Question: What does this figure show? Answer in one sentence.
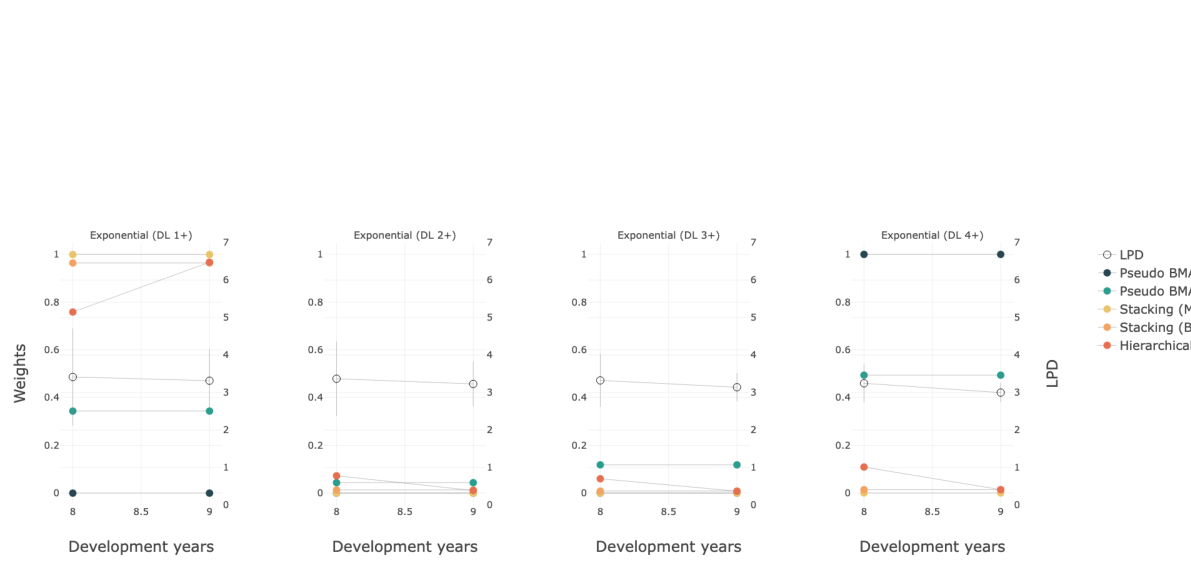
Answer: Model weights and log posterior predictive density (LPD) values from the loss de- velopment example. Model weights are constant across development years for every model except the hierarchical stacking model, which included development year as a discrete covari- ate. The left y-axis illustrates the weight values for each of the blending models. The right y-axis denotes the mean (open circles) and 1 standard deviation across programs (vertical line segments) LPD values.